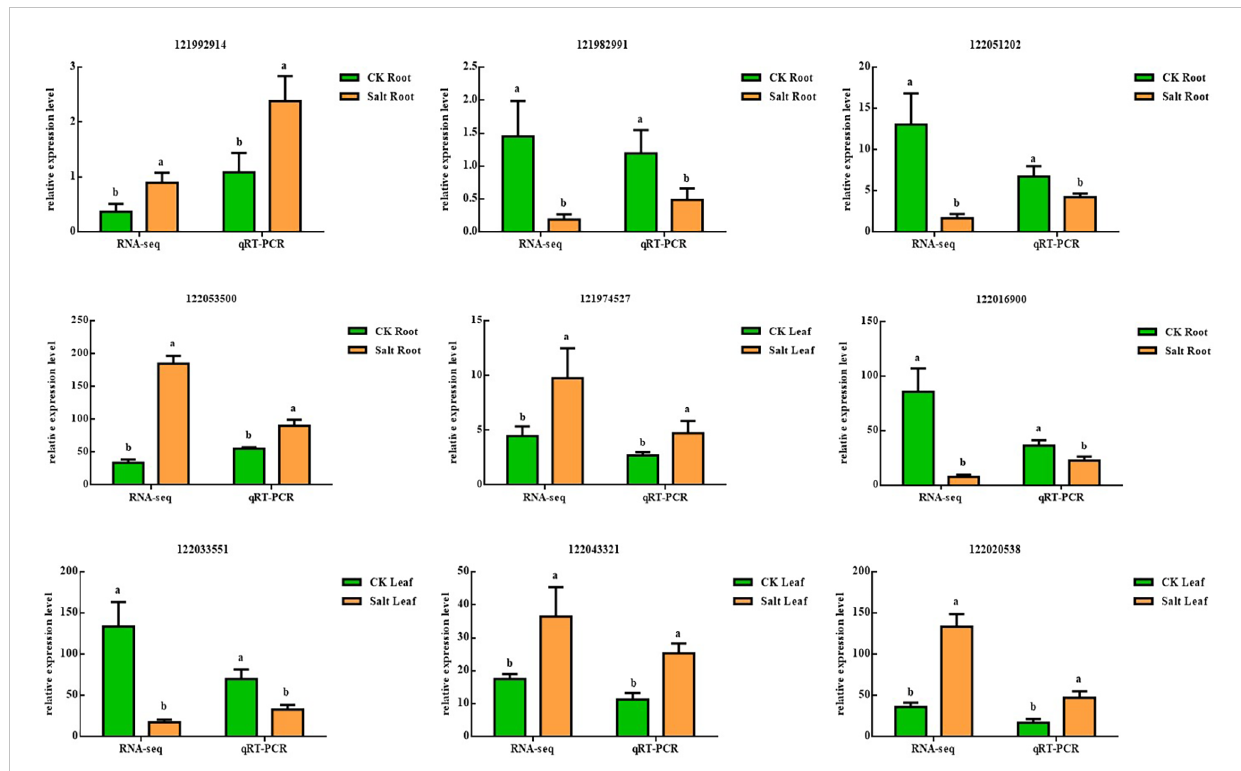
FIGURE 8 Validation of nine differentially expressed genes using real-time quantitative PCR in salt-stressed ginger seedling roots and leaves, P < 0.05. The lowercase letters a and b mean the letter markers for signi fi cant difference